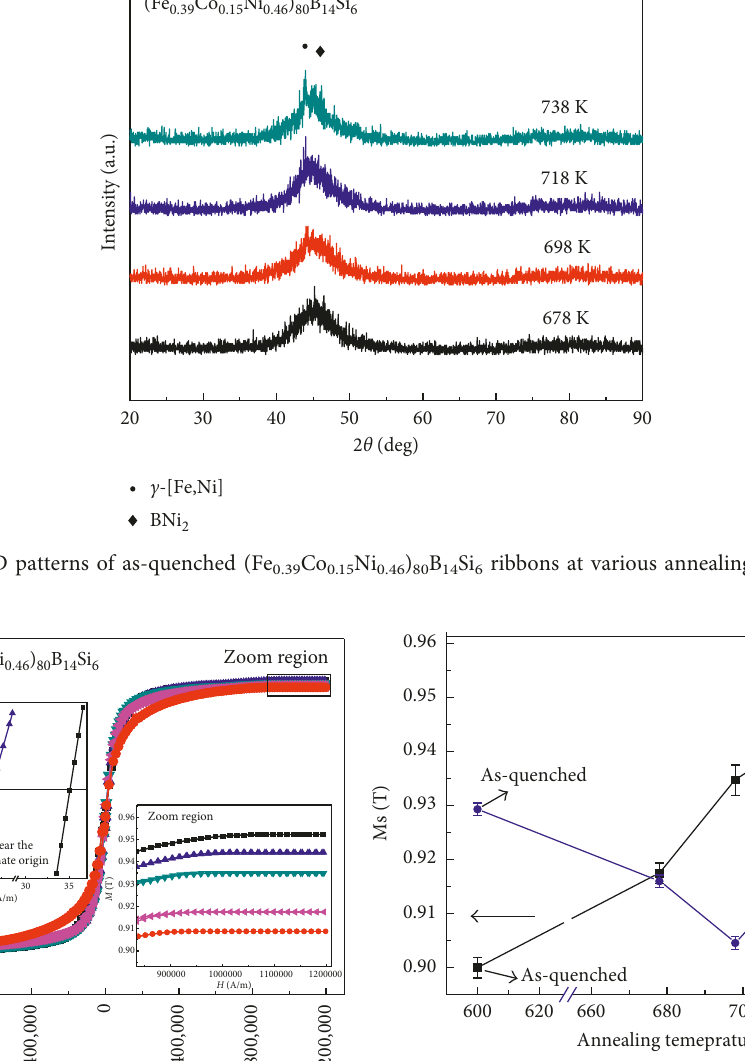
0.39 Co 0.15 Ni 0.46 ) 80 B 14 Si 6 ribbon on the